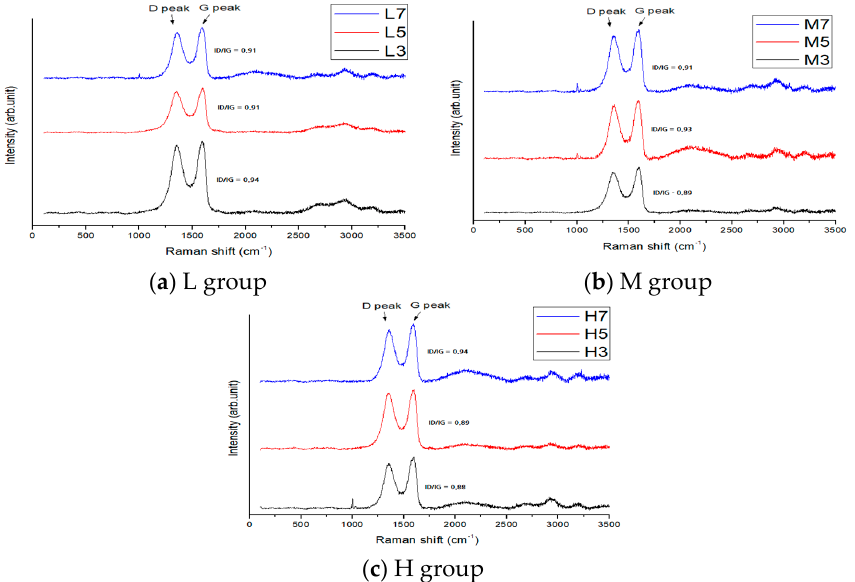
Figure 4. Raman spectra of the L, M, and H groups. The G peak in all groups is the characteristic peak of graphene oxide (GO). The ID/IG values range from 0.88 to 0.94, indicating similar defects.